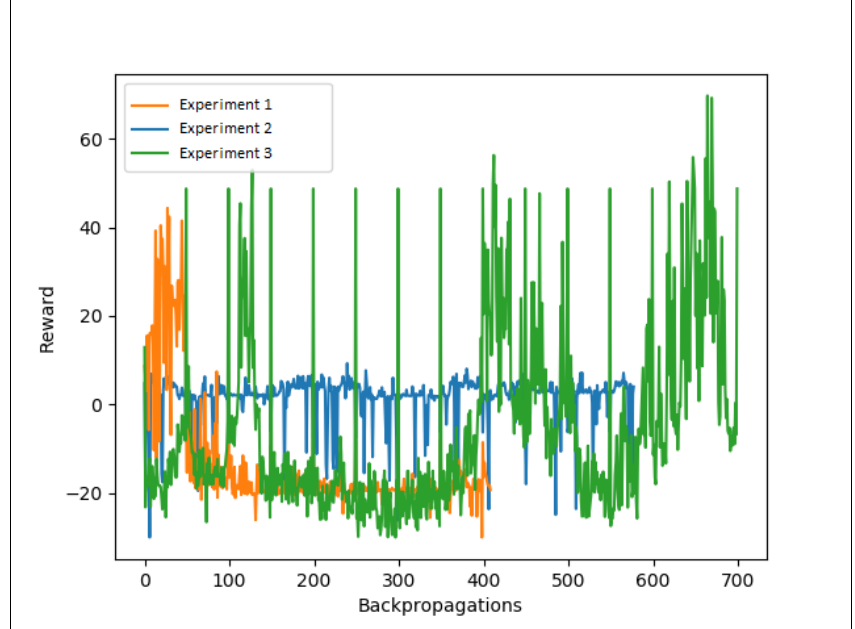
Figure 4. Normalized